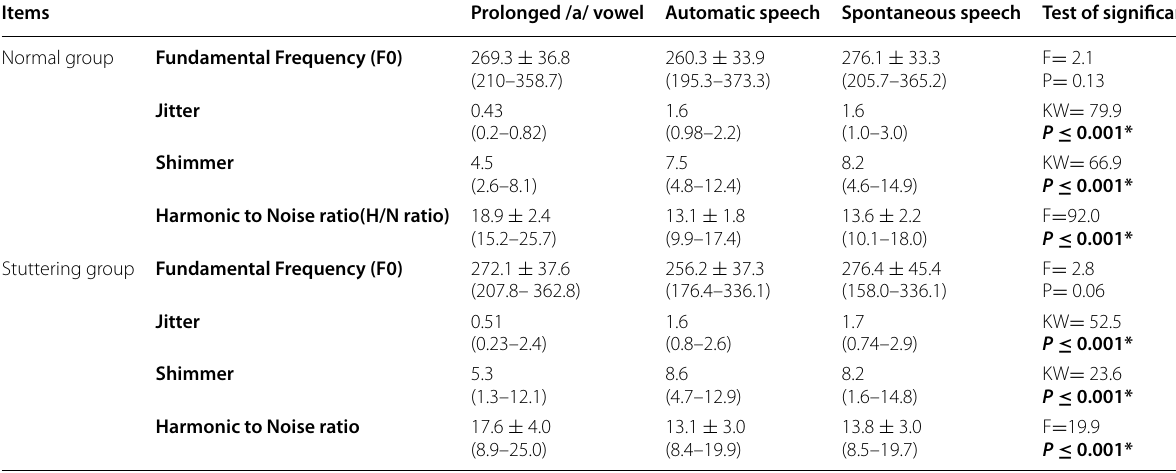
Data expressed as mean